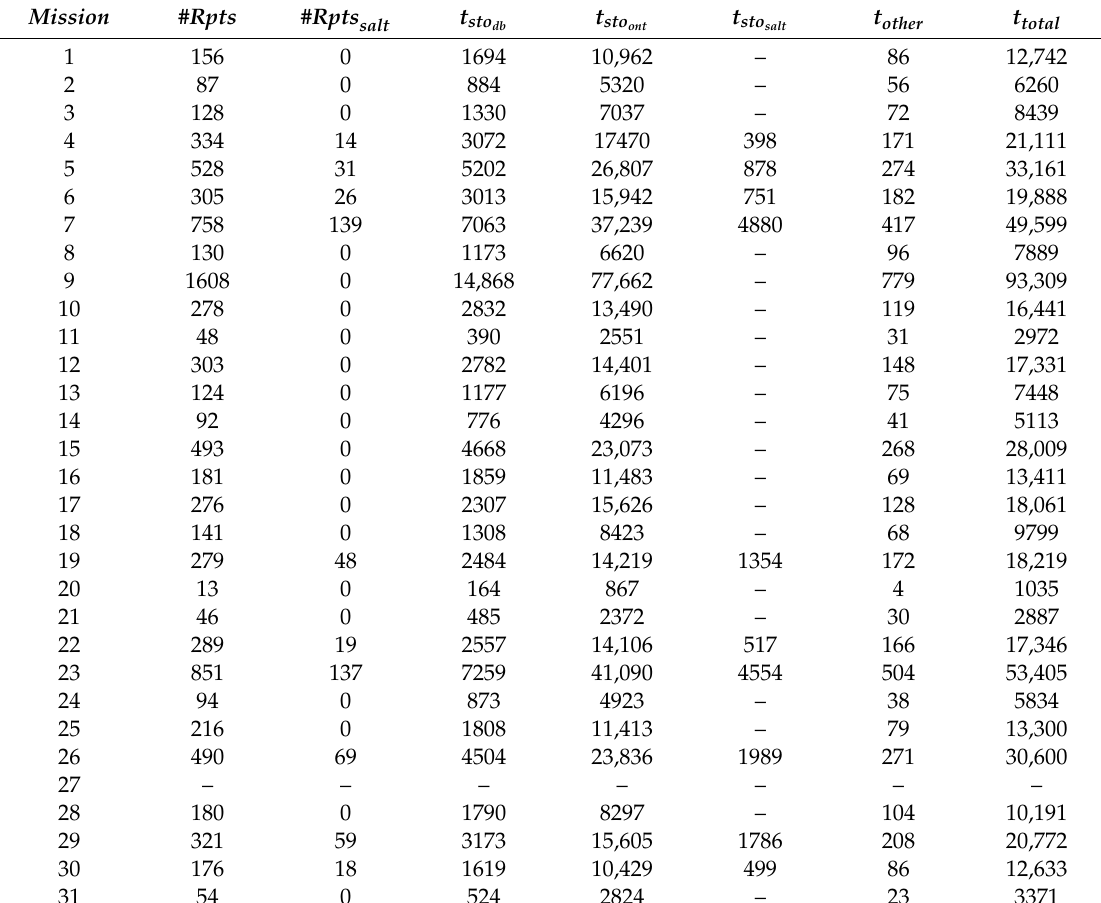
Table 7. Values for processing the state vector report. Time is given in